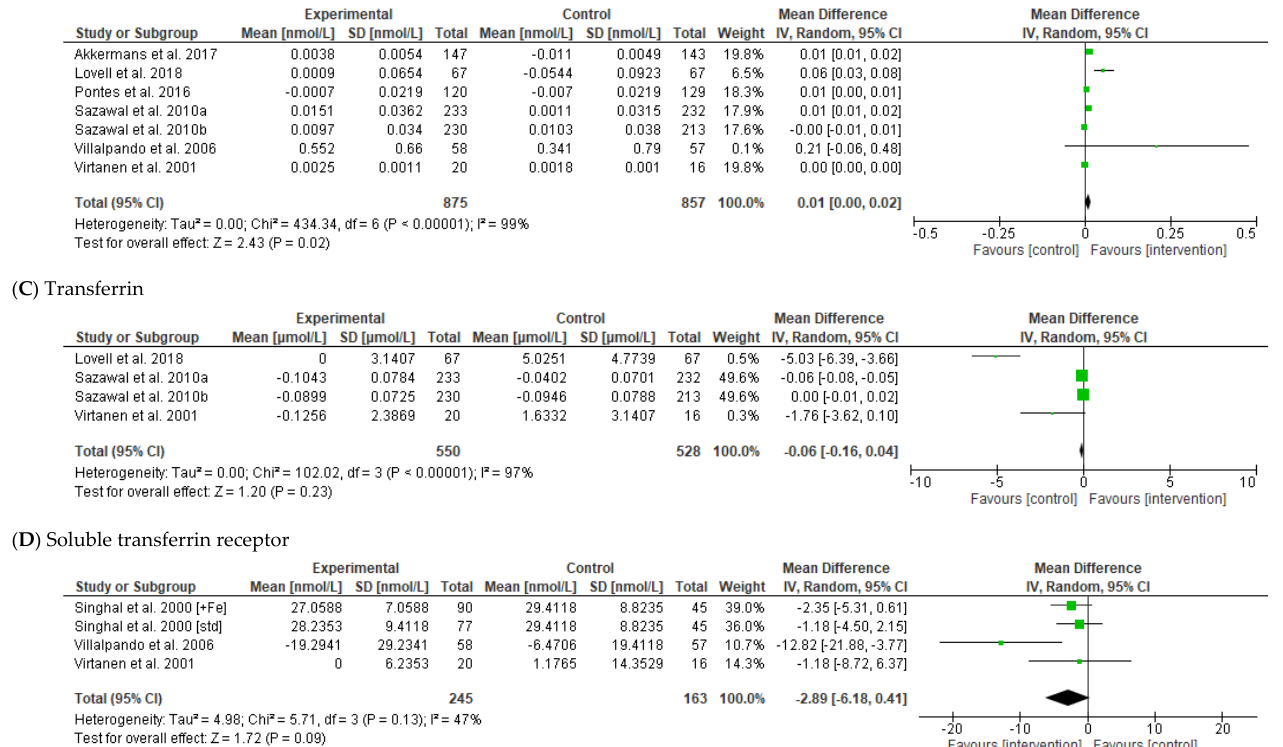
Figure 3. Forest plot displaying the effect of fortified milk (intervention) compared with control milk on mean difference in ( A ) haemoglobin (g/L) [29,31,33–37,41,43]; ( B ) ferritin (nmol/L) [31,33–37,41]; ( C ) transferrin ( µ mol/L) [31,34,36,37]; ( D ) soluble transferrin receptor (nmol/L) [34,37,46]. Note: The study-specific mean differences and 95% confidence intervals are represented by the green squares and horizontal lines, respectively. The size of the square represents the weight given to each study in the meta-analysis. The shaded diamond represents the pooled mean difference, and the width of the diamond represents the pooled 95% confidence